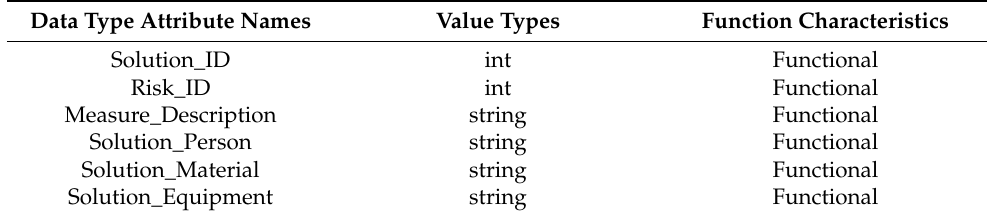
Table 7. Safety measure data type attribute definition.